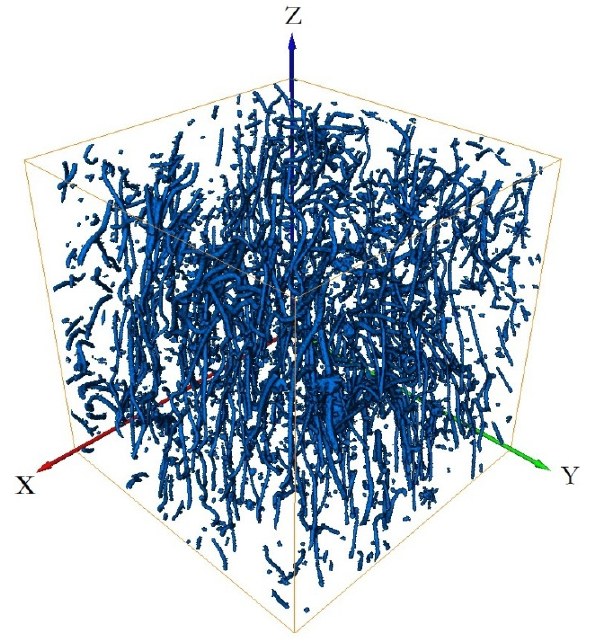
Figure 12. Avizo software reconstructs a polyester short fiber image for the first time.